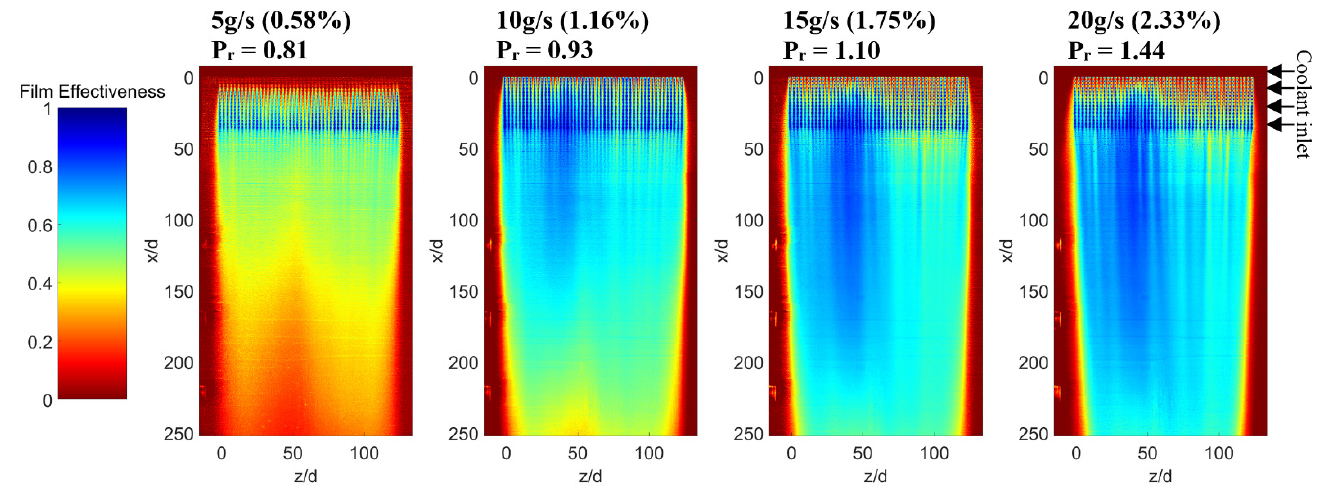
Figure 7. Film effectiveness of Panel 5 at different coolant mass flow rates (mass fraction).